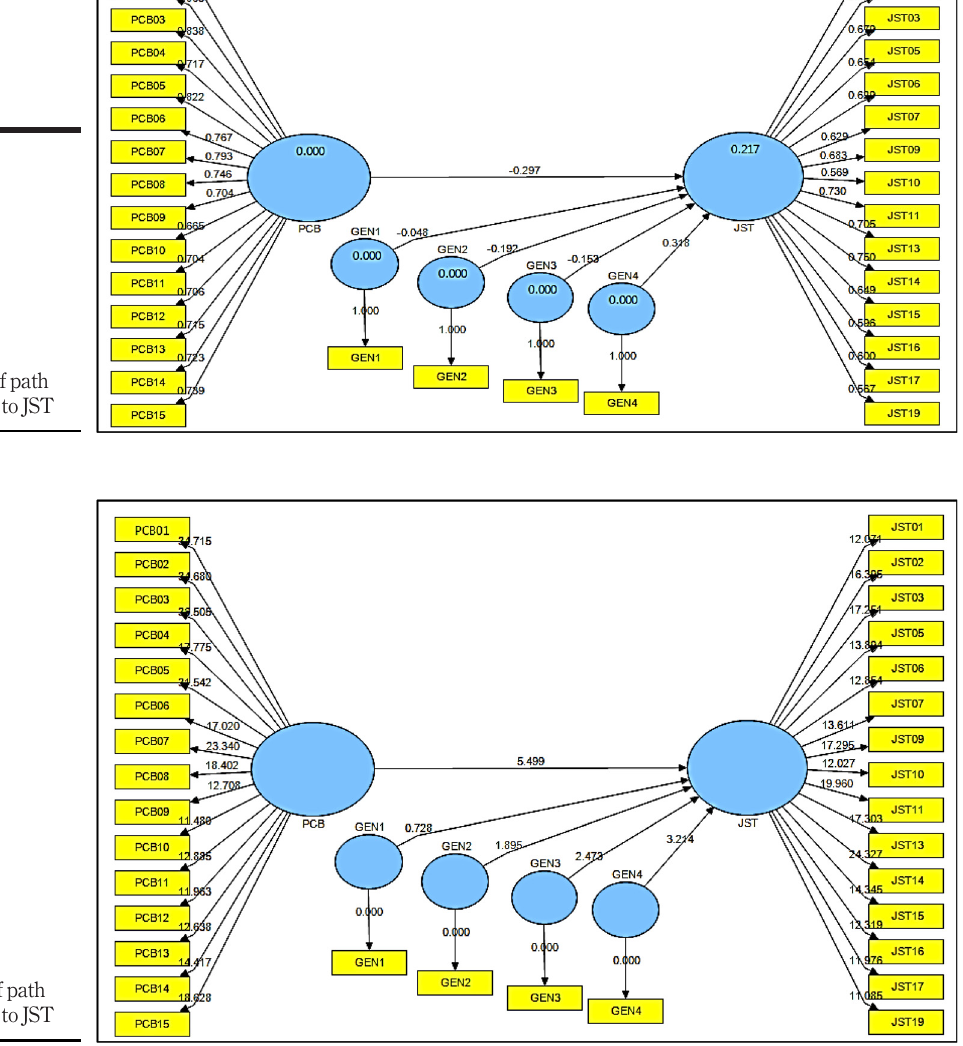
Figure 3. T -statistic of path linking PCB to